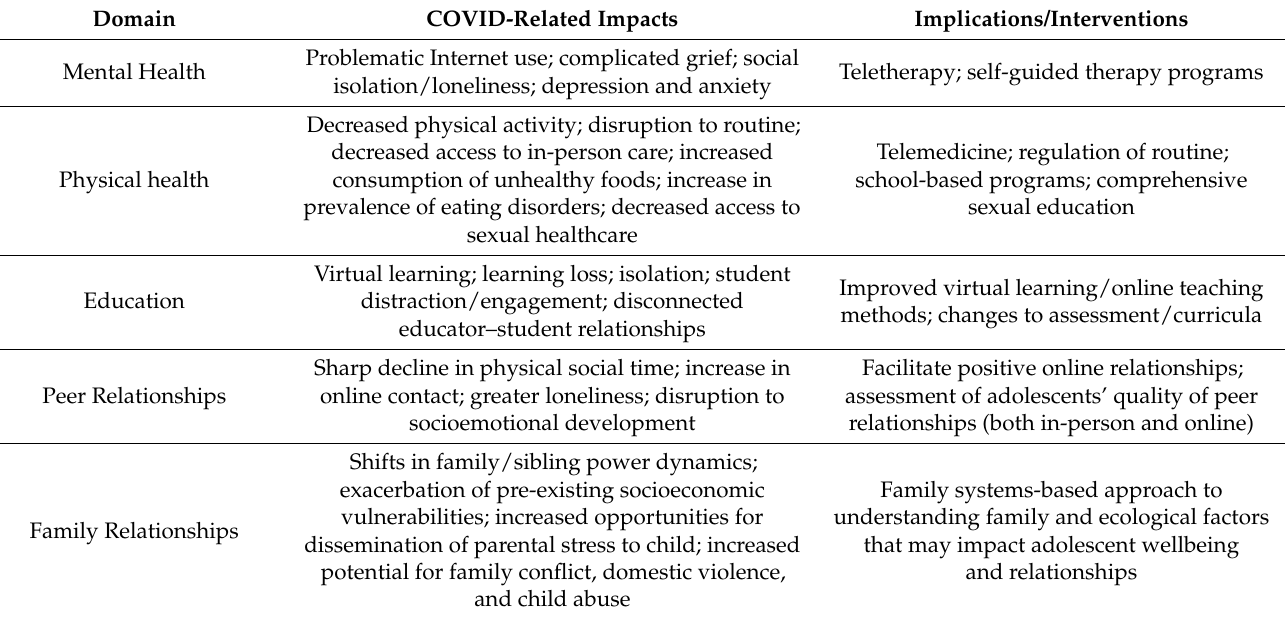
Table 1. Summary of